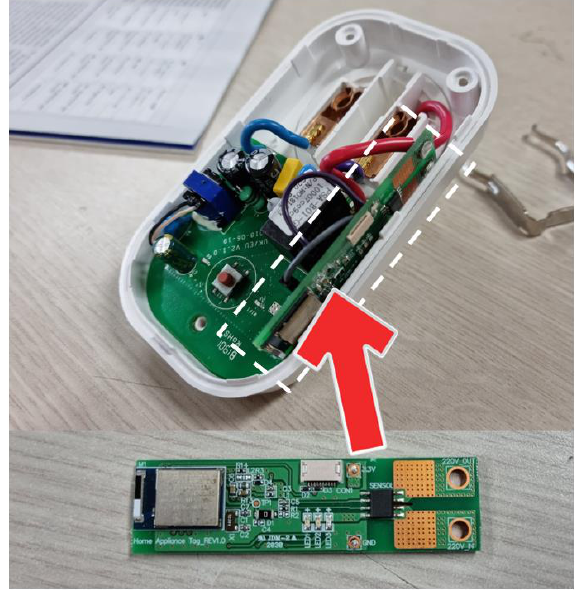
Figure 12. current sensing tag board. Figure 12. Current sensing tag board.